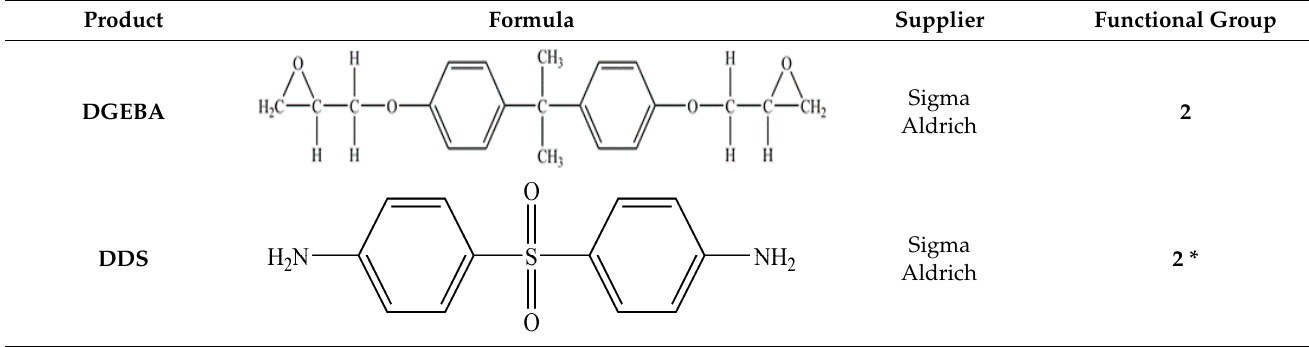
Table 2. Characterization methods.